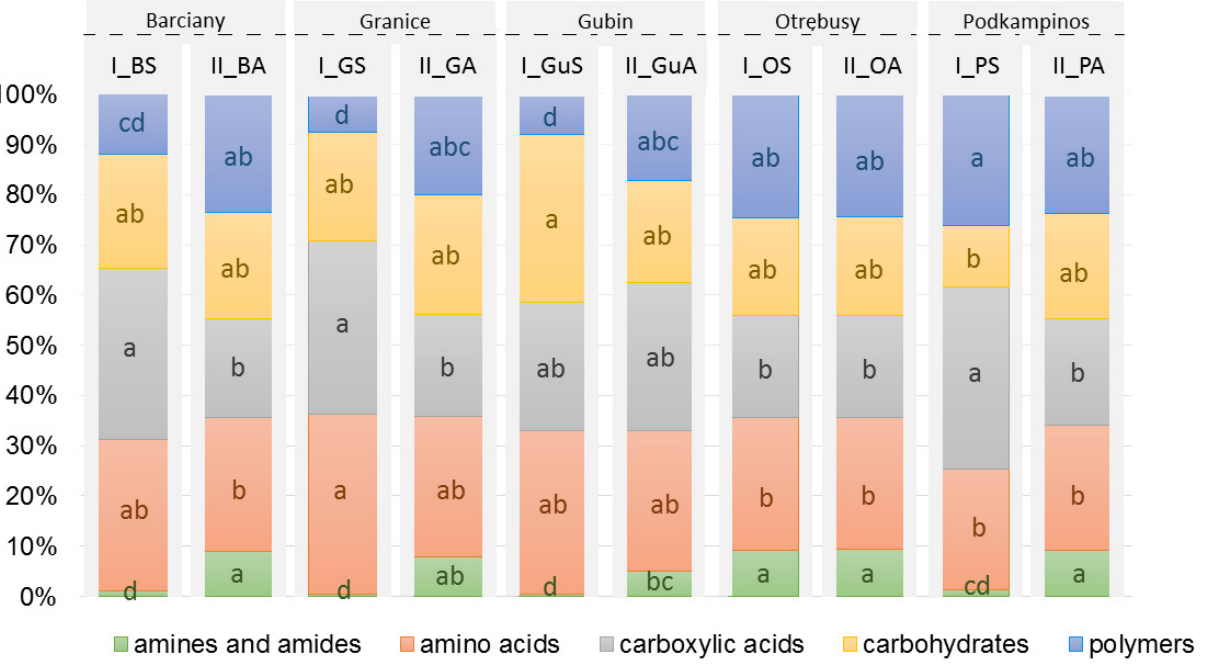
Figure 2. Relative utilisation of categorised carbon sources: amines and amides, amino acids, carboxylic and acetic acids, carbohydrates and polymers. after 168 h of plate incubation. Different letters indicate significant differences ( p < 0.05, n = 3) by Tukey’s HSD test.